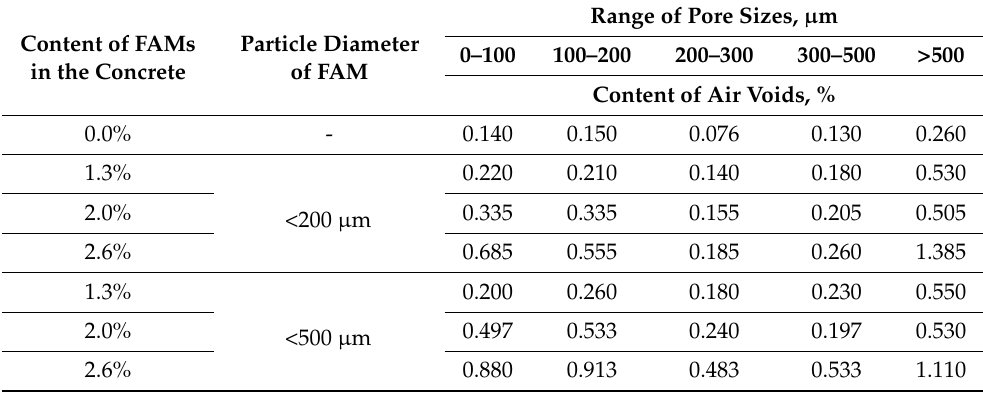
Table 6. Pore size distribution of air voids in the concrete with fly ash microspheres (FAM).